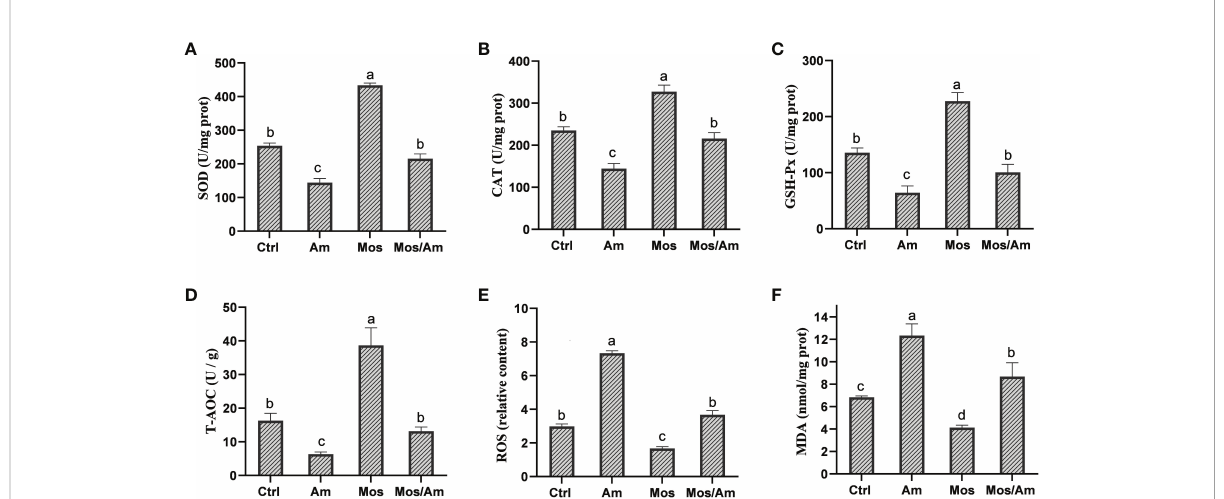
FIGURE 2 Effects of dietary MOS on the antioxidant capacity of the common carp under ammonia stress for 30 days. Values are expressed as mean ± standard error (SE) from triplicate groups. Bars with different letters differ signi fi cantly from those of other groups (P<0.05). SOD activity (A) , CAT